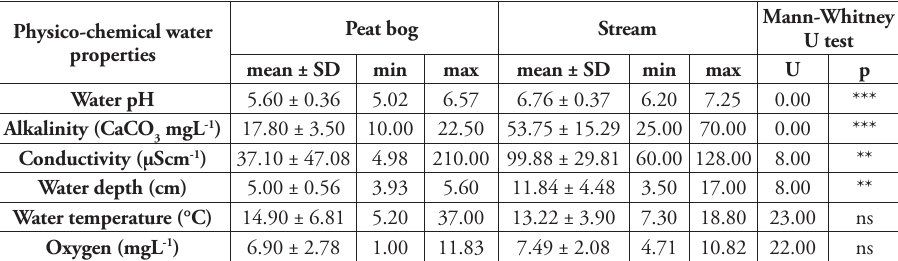
Table 1. Comparison of physico-chemical water properties between the Đon močvar peat bog and adja- cent stream using Mann-Whitney U test. Key: *** p<0.001, ** p<0.01, ns non-significant. The values are mean ± standard